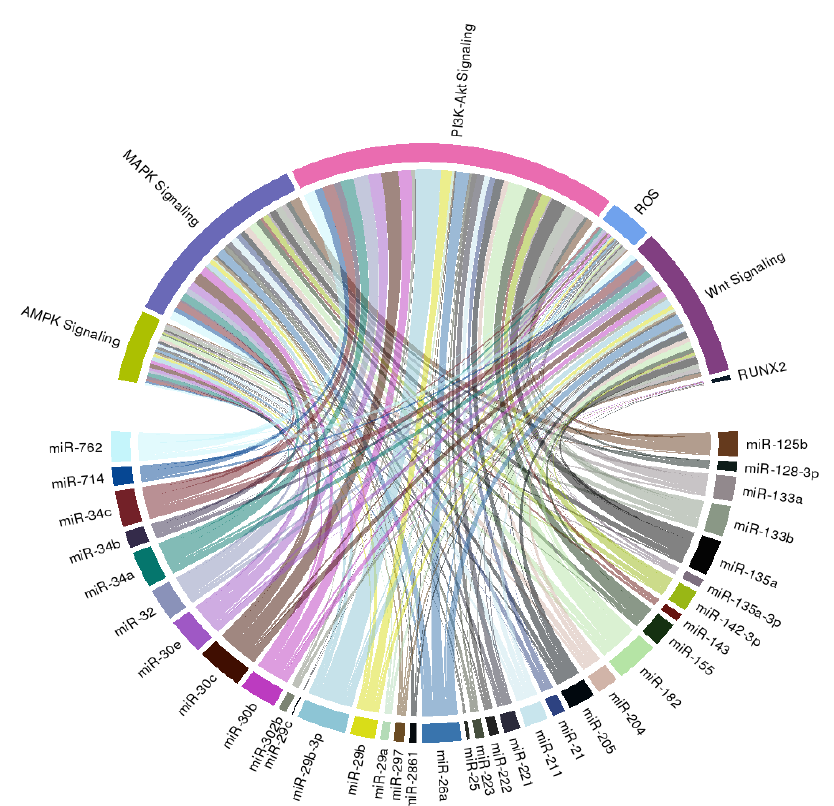
Figure 2. A circular ribbon chart depicting interactions between literature-identified miRNAs in Table 1 and known molecular mediators of vascular calcification. The thickness of the ribbon is reflective of the scores assigned by the literature addressing the relationship based on miRNAtap (R package version 1.16.0; R foundation for Statistical Computing, Vienna, Austria) and topGO (R package version 2.34.0; R foundation for Statistical Computing, Vienna, Austria).